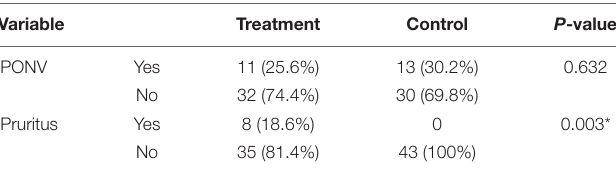
TABLE 3 | Incidence of adverse event on pregnant women undergoing C/S under spinal anesthesia (SA) in Dilla University Referral Hospital, 2021/22. Variable Treatment Control P